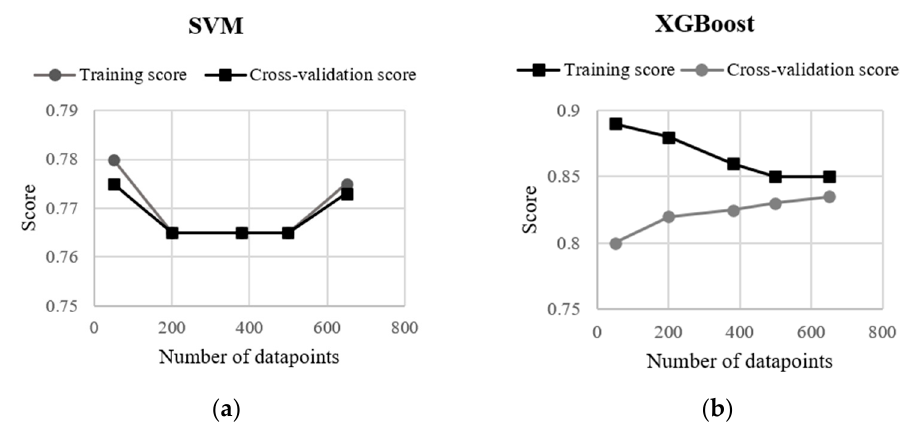
Figure 7. Learning curves on training and test datasets by ( a ) SVM and ( b ) XGBoost algorithms.